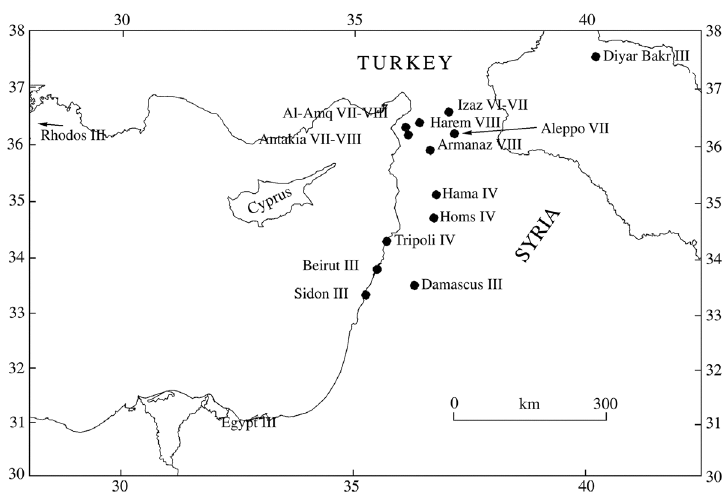
Fig. 19. Map of intensity distribution for April 3, 1872